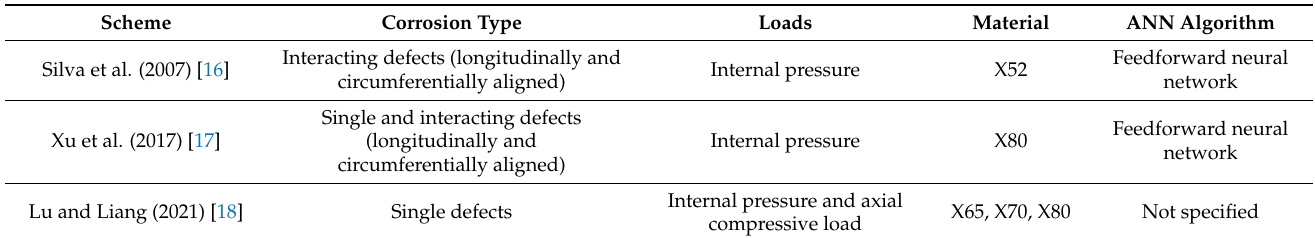
Table 1. ANN based on FEA dataset to predict the failure pressure of corroded